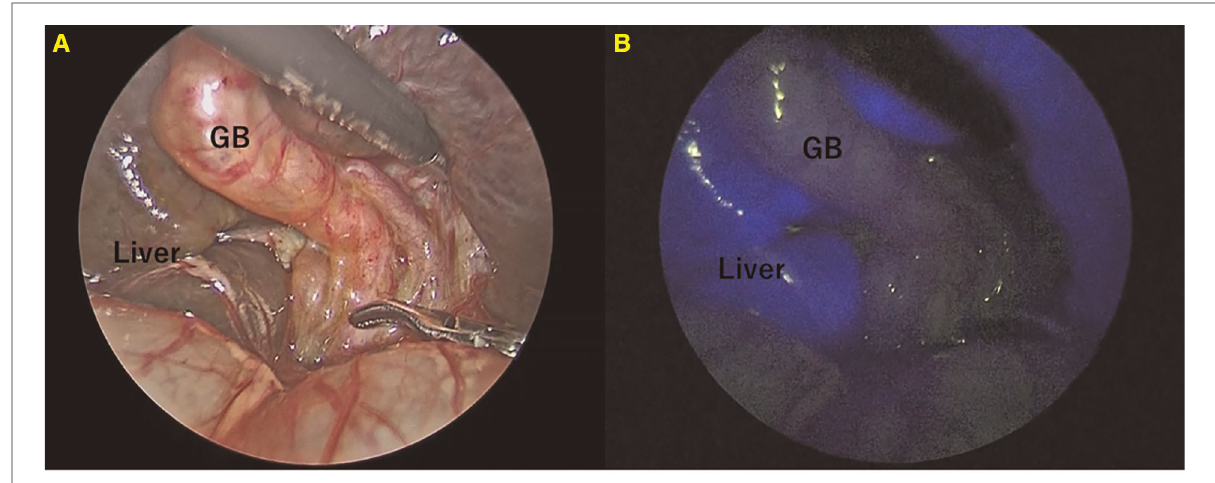
FIGURE 2 Fluorescence cholangiography in patients with biliary atresia. Only the liver appeared to fl uoresce strongly. ( A ) Normal view. ( B ) Fluorescence